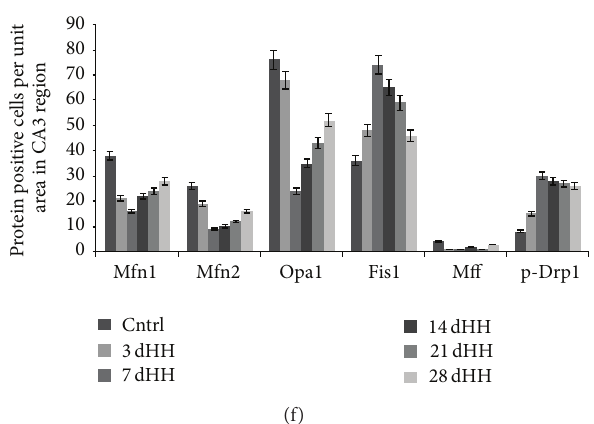
Figure 4: Representative photomicrograph of temporal alteration in Mfn1, Mfn2, Opa1, p-Drp1, Mff, and Fis1 protein expression due to HH exposure in (a), CA1 (b) expression of proteins in CA1 region and (c) graphical representation showing cell count expressing protein in CA1 region (d) CA3 (e) expression of protein in CA3 regions of rat hippocampus (f) bar graph presents cell count expressing protein in CA3 region. Data are expressed as mean ± SEM; 𝑛 = 3 . Scale bar depicted in the figures is equivalent to 10 𝜇 m